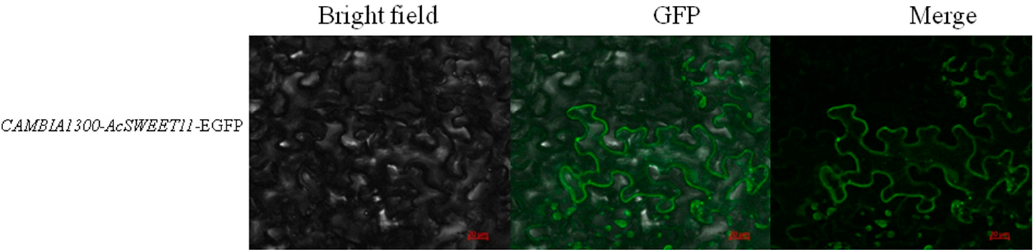
Figure 6. Subcellular localization analysis of AcSWEET11 in Nicotiana benthaminana leaves after 2 days of agrobacterium injection. Scale bars = 20 μ m.